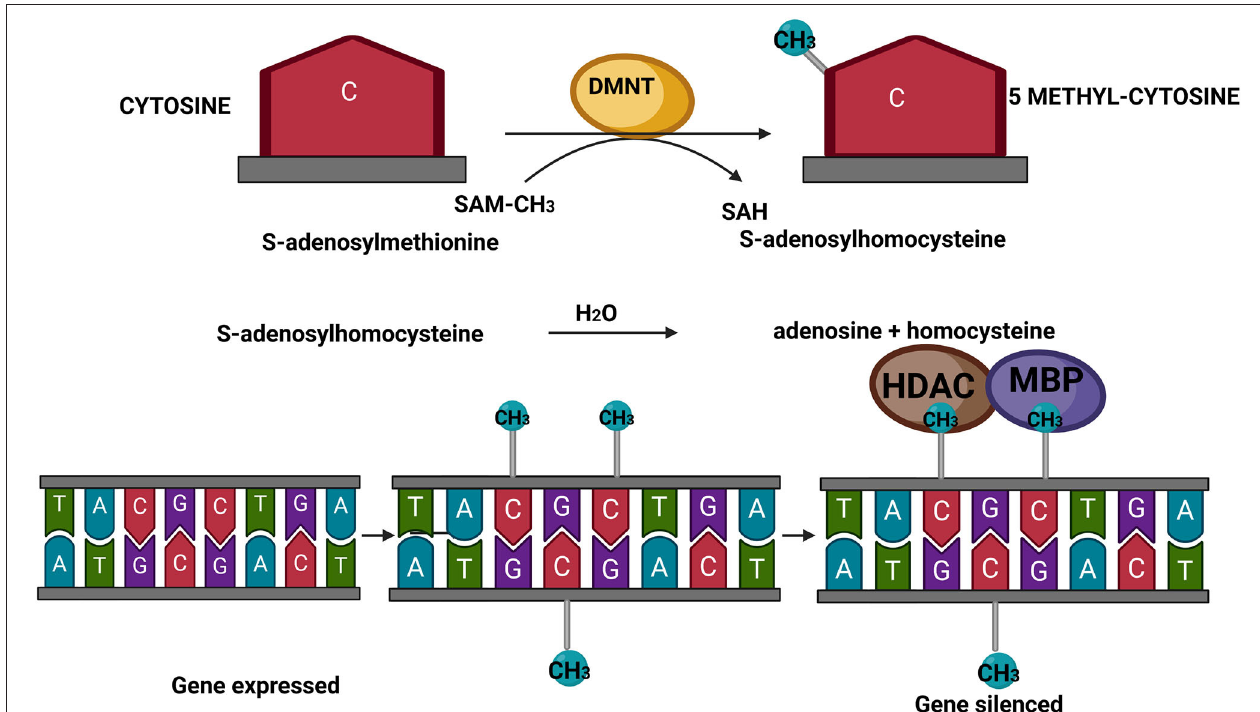
FIGURE 1 | Schematic presentation of DNA methylation. SAM, S-adenosyl methionine; SAH, S-adenosylhomocysteine; DNMTs, DNA methyltransferases; MBPs, methyl-binding proteins; HDACs, histone deacetylases. Created with